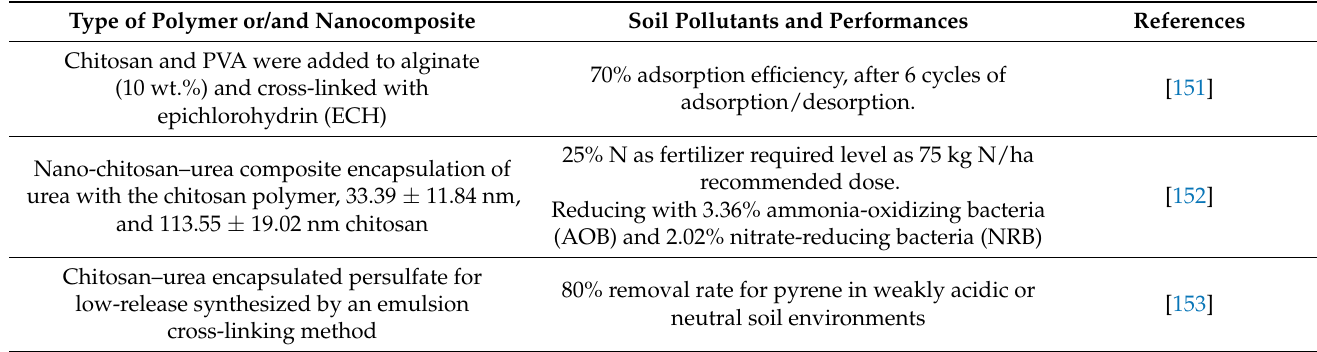
Table 3. Natural polymers and their nanocomposites used for soil